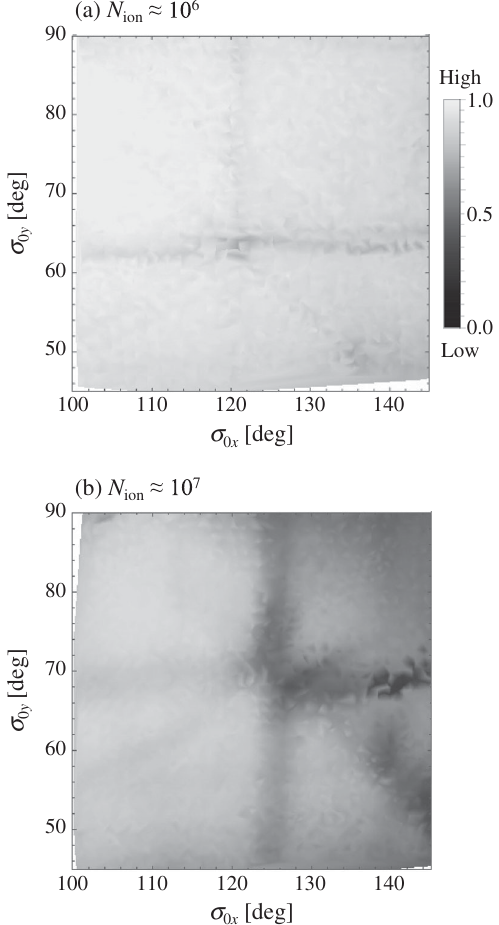
FIG. 11. Tune diagrams of the quadrupole doublet beam transport. The transverse tune space above σ 0 x ¼ 100 ° and below σ ¼ 90 ° in Fig. 10 is magnified to search for a weak coupling 0 y resonance line. The number of ions ( N ) initially stored in the ion LPT is about 10 6 in the upper picture (a), and 10 7 in the lower picture (b). The storage period of ions in the LPT is fixed at 10 ms in both cases. Each picture consists of 3969 data